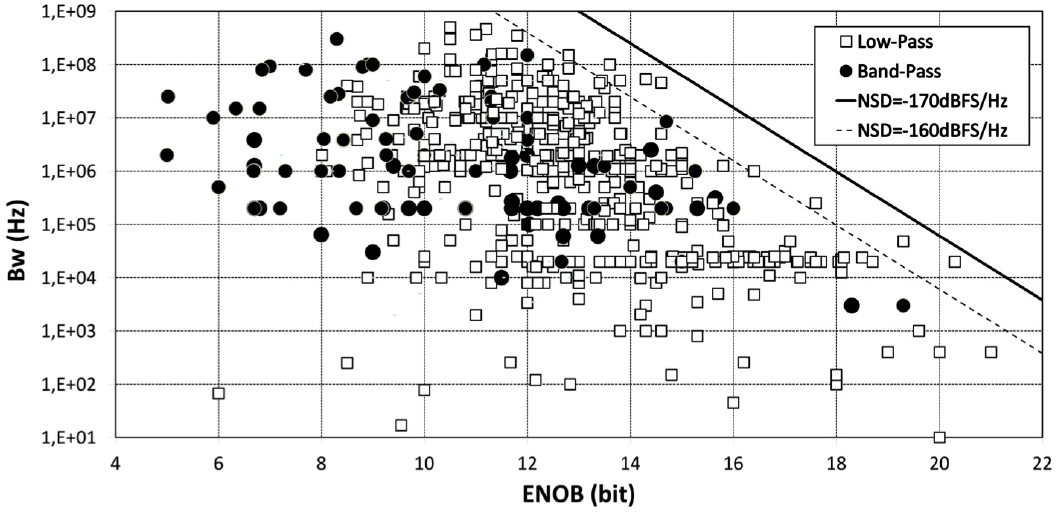
Figure 12. Aperture plot of Σ∆ Ms: BP- Σ∆ Ms vs. LP- Σ∆